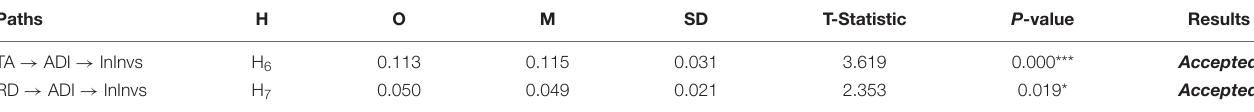
TABLE 6 | The indirect effects of the variable. Paths H O M SD T-Statistic P -value TA → ADI → InInvs H 6